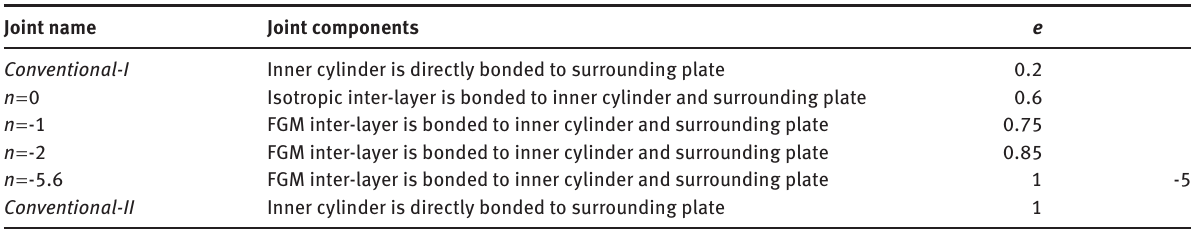
Table 2: Numeric constants of analyzed FGM models.